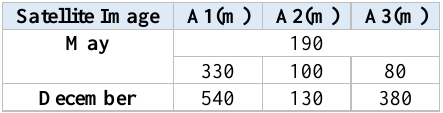
Table 2. Threshold distance (meters) from Incremental